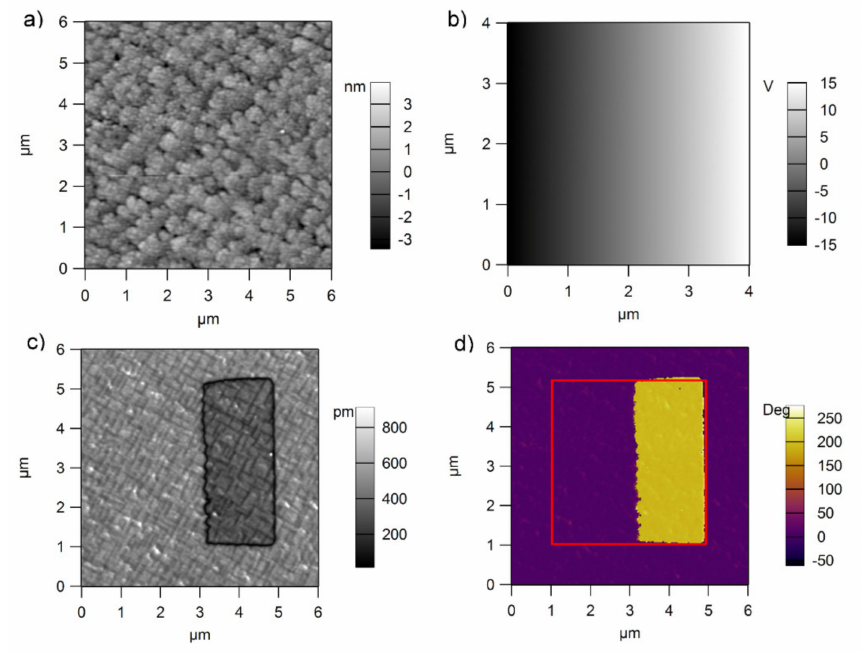
Figure 6. Topography ( a ), poling map ( b ) amplitude ( c ) and phase ( d ) of the PFM signal obtained after poling in the case of the PZT films deposited from commercial targets on a single crystal STO substrate with a bottom SRO electrode. The root mean square on the topography image (RMS) was estimated to about 0.5 nm.